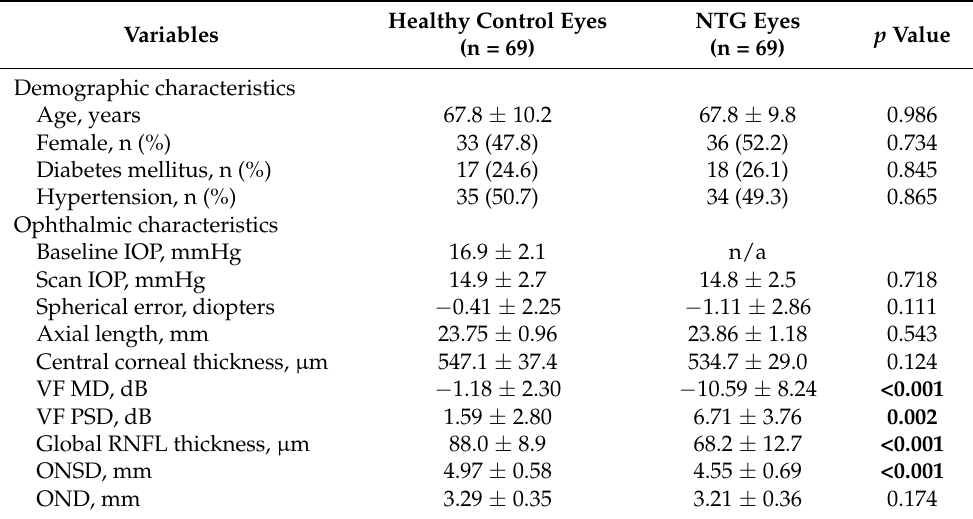
Table 1. Demographic characteristics of the study subjects.